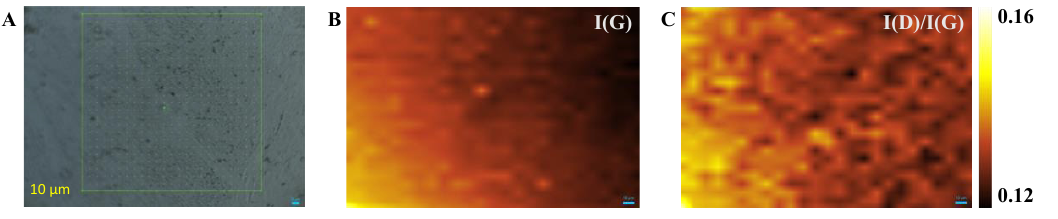
Figure 3: Raman mapping results. (A) Scanned area of Raman mapping under the excitation of 532 nm with a step of 10 µm. (B) Integrated intensities map for G -band. (C) Integrated intensities map for D -band/ G